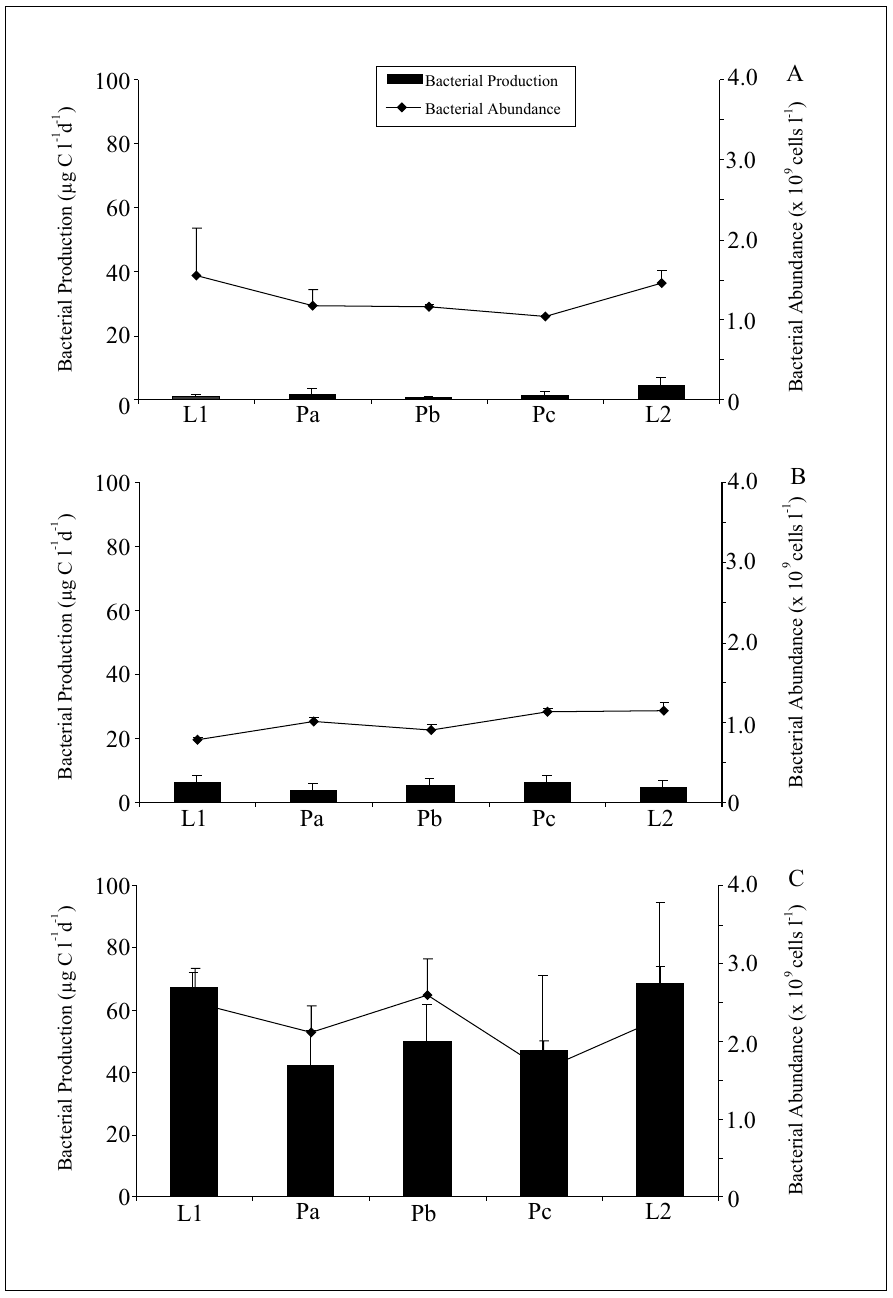
Fig. 1 – Bacterial production and abundance in samples from Cabiúnas Lagoon (A), Lake Stechlin (B) and Lake Dagow (C). L1 – littoral without macrophytes, Pa – pelagial surface, Pb – pelagial intermediate, Pc – pelagial bottom and L2 – littoral with macrophytes. Vertical bars represent the average + standard